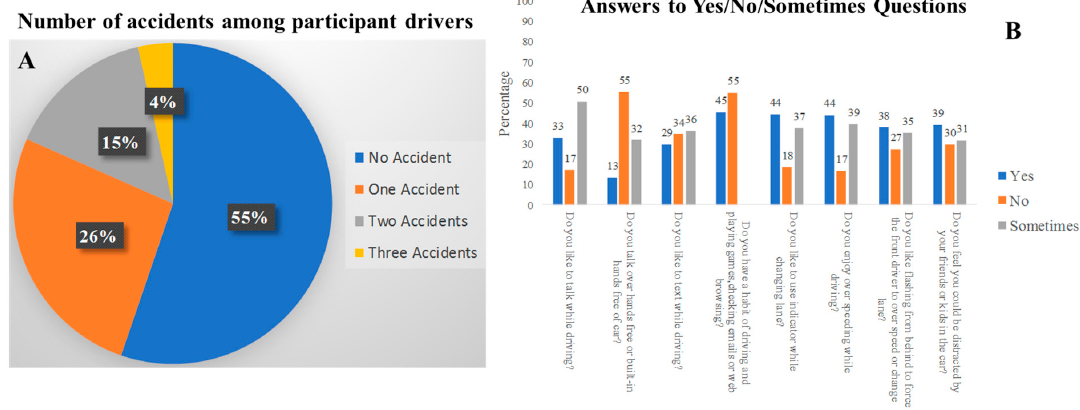
Figure 12. ( A ) Statistics of number of accidents and ( B ) results of some yes/no/sometimes questions among the survey participants.